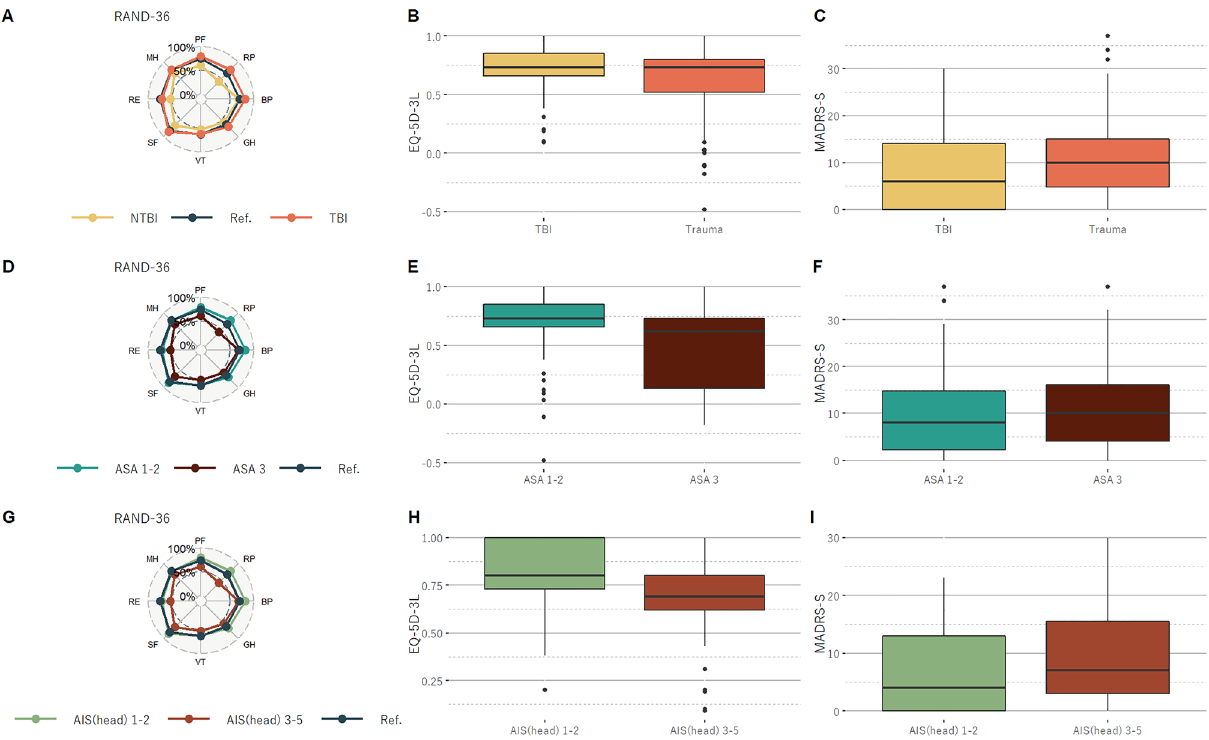
Figure 2. Health-related quality of life (HRQoL) assessed with RAND-36 ( A,D,G ) and EQ-5D-3L ( B,E,H ), and symptoms of depression assessed with Montgomery Åsberg depression Rating Scale self-report (MADRS-S) ( C,F,I ), comparing trauma patients with a concomitant traumatic brain injury (TBI) to trauma patients without (NTBI) ( A,B,C ), no or few comorbidities (ASA-score 1–2) to severe systemic morbidity (ASA-score 3) ( D,E,F ), and TBI severity defined by Abbreviated Injury Severity (AIS) head score of 3 ( G,H,I ).